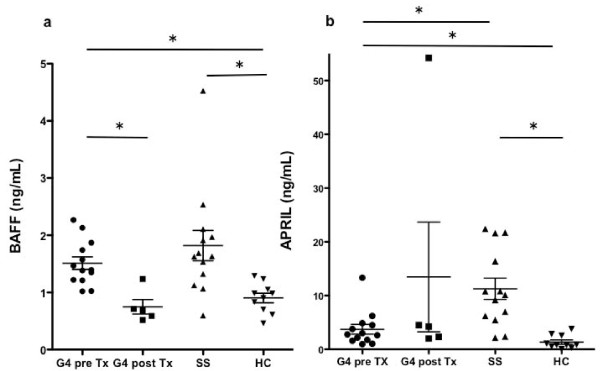
Serum levels of BAFF and APRIL in IgG4-RD. (a) Serum levels of BAFF in patients with IgG4-RD before (G4 pre Tx) and after (G4 post Tx) treatment with glucocorticoids (GC). (b) Serum levels of APRIL in patients with IgG4-RD before (G4 pre Tx) and after (G4 post Tx) treatment with GC. Mean ± Standard deviation (SD) are shown. *, P < 0.01. HC, healthy controls; SS, patients with Sjögren syndrome; Tx, treatment.